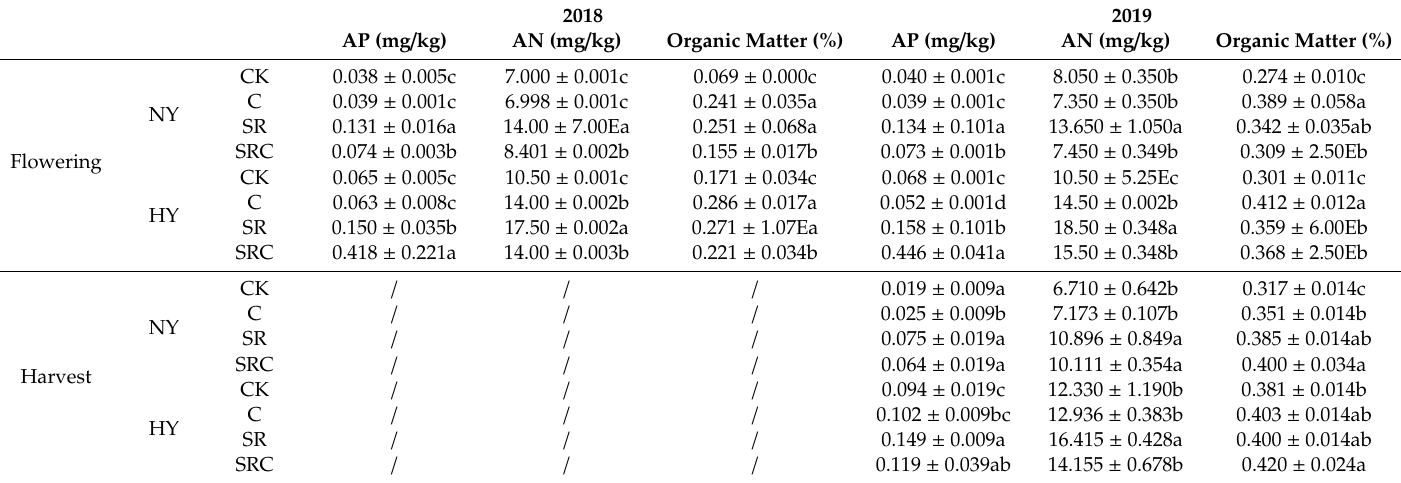
Table 5. E ff ects of biochar and soft rock treatments on soil properties at two fertilizer levels.